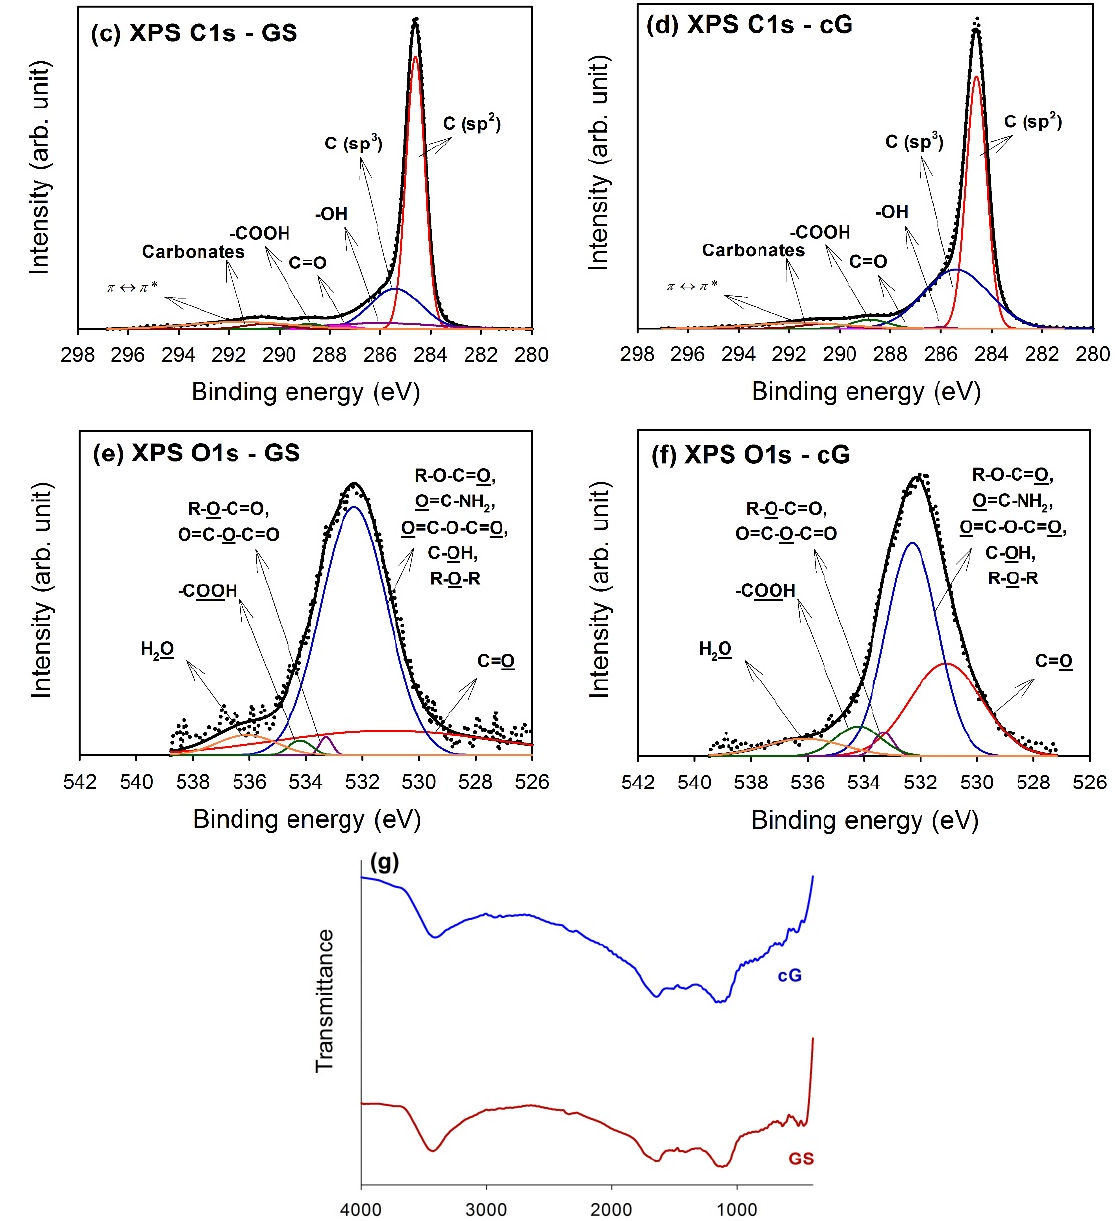
Figure 5. Chemical states of GS and cG. ( a ) XPS survey scan spectra; ( b ) surface atomic ratios; ( c ) and ( d ) curve fitting of high resolution XPS C1s spectra; ( e ) and ( f ) curve fitting of high resolution XPS O1s spectra; ( g ) FT-IR spectra.